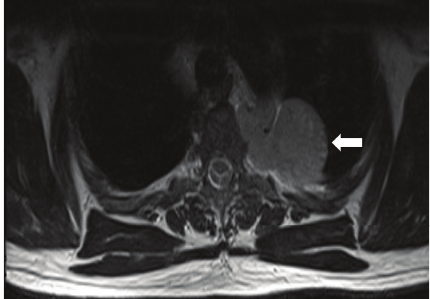
Figure2:CTthoraxwithintravenouscontrastina50-year-oldmale patient with Castleman disease. A 5cm well-circumscribed, lobu- lated mass lesion with homogenously intense contrast enhancement is seen in the left posterior pleural space in a paraspinal location (arrow).